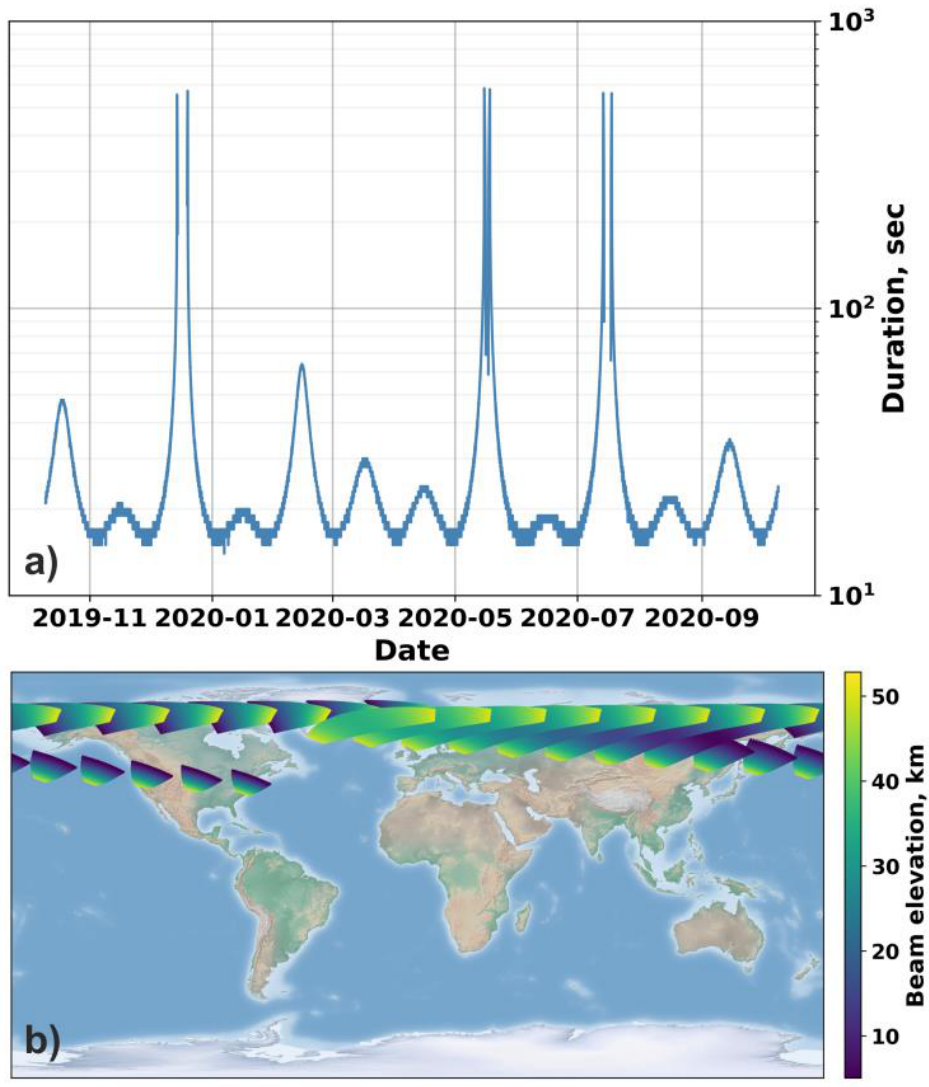
Figure 10. ( a ) Sun observation’s durations per one revolution within the range of tangent heights of 5 – 50 km in one year flight of MLHS placed on the ISS orbit. ( b ) The Earth’s surface coverage by MLHS measurements within 24 h. The color bar indicates the minimal tangent height of the current measurements. (For interpretation of the references to color in this figure, the reader is referred to the web version of this article).